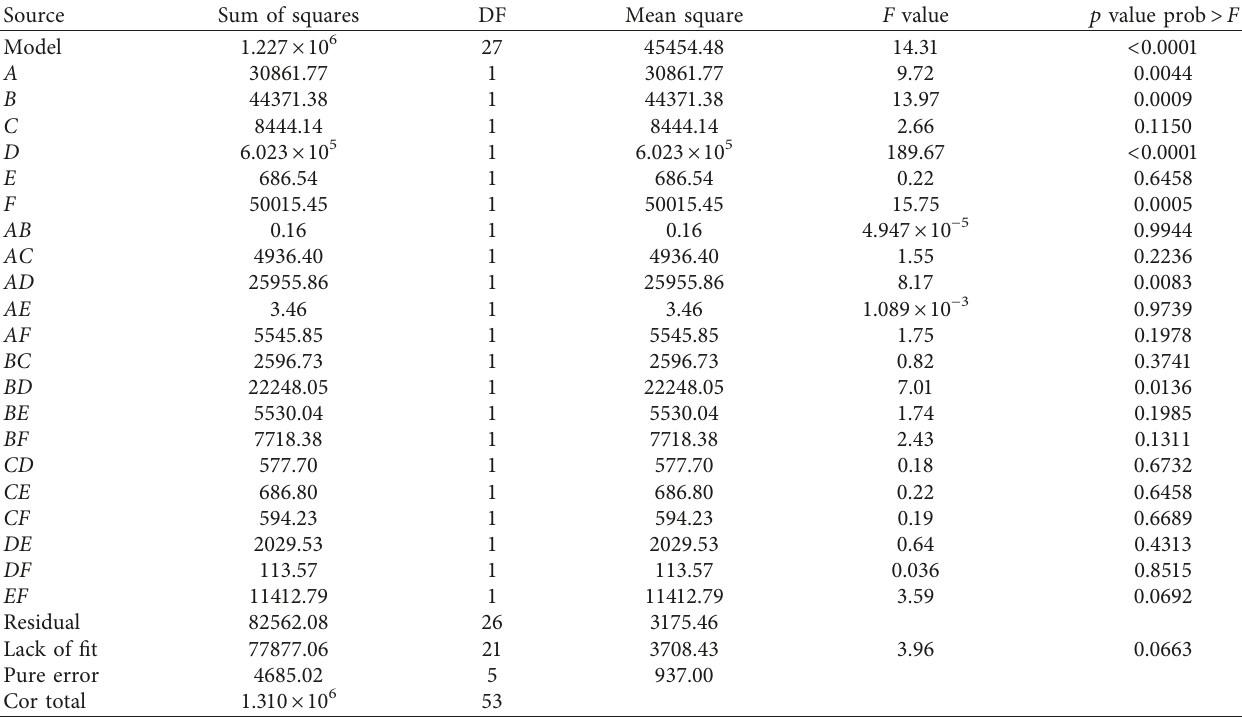
Table 6: Analysis of variance of tensile strength.